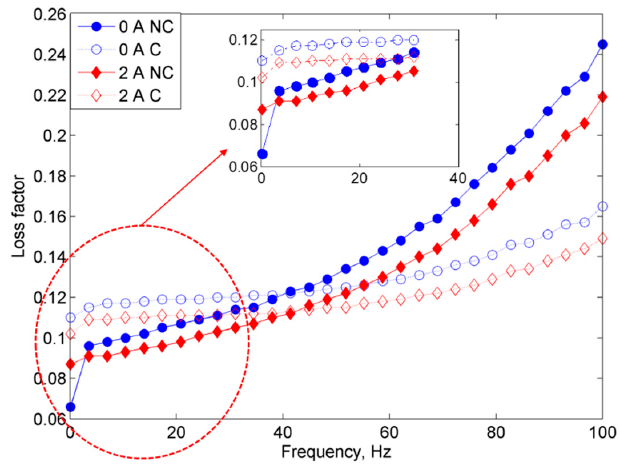
Figure 8. Comparison of loss factor vs. frequency for MRE samples of non-corroded (NC) and corroded (C) CIPs at off- and on-state conditions.